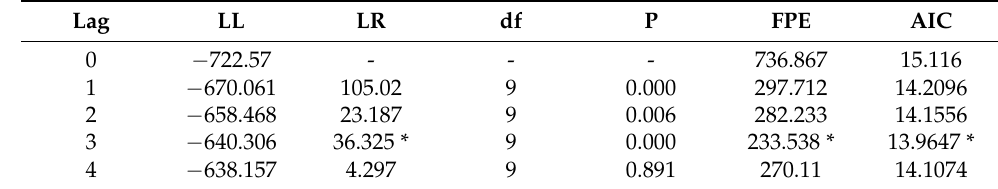
Table 3. Optimal lag length concerning the electricity consumption of the whole of society.